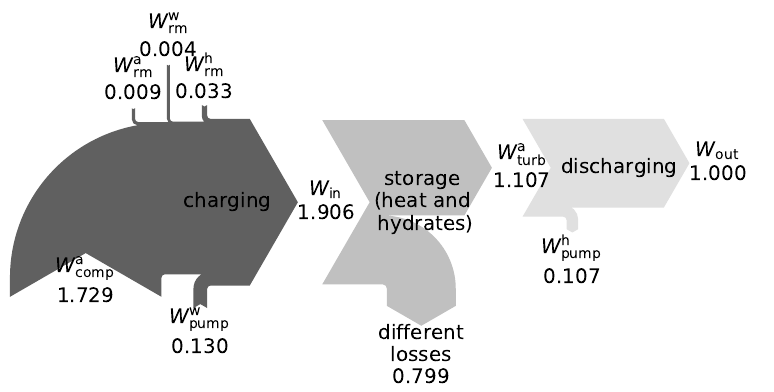
Figure 3. Sankey diagram to illustrate the relation between works (normalized to W out ) occurring in the SAES reference case.